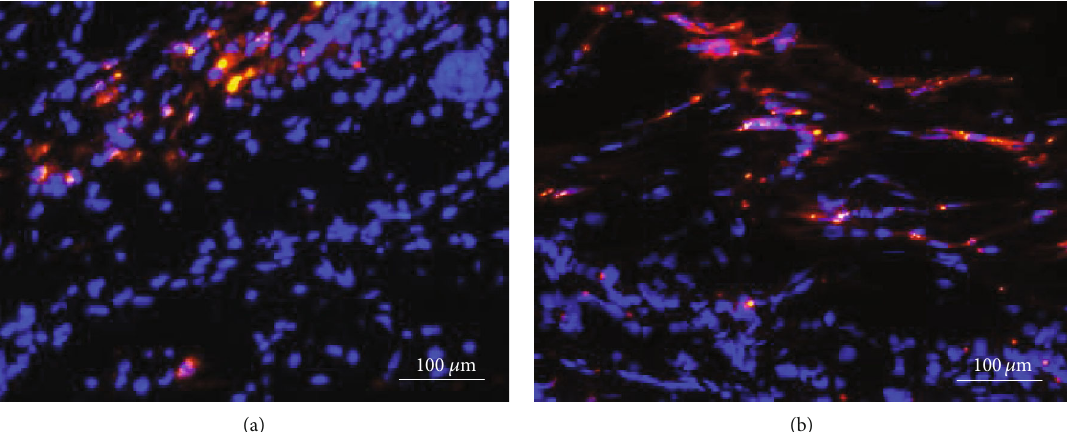
Figure 3: Immuno fl uorescence of adipose-derived stromal cells (ADSCs) in auricular cartilage defects. ADSCs labeled with the red Cell Tracker CM-Dil dye were detected in the ADSC group at 4 (a) and 8 weeks (b) after ADSC injection.